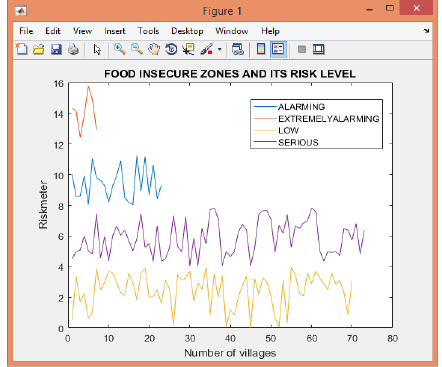
Figure 12. Matrix representing number of villages